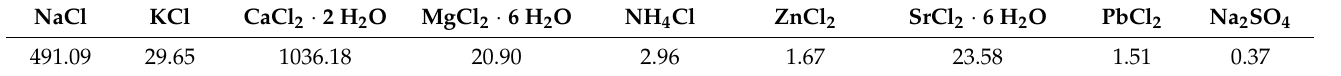
Table 2. Chemical composition in grams of 5 L Northern German Basin (NGB)